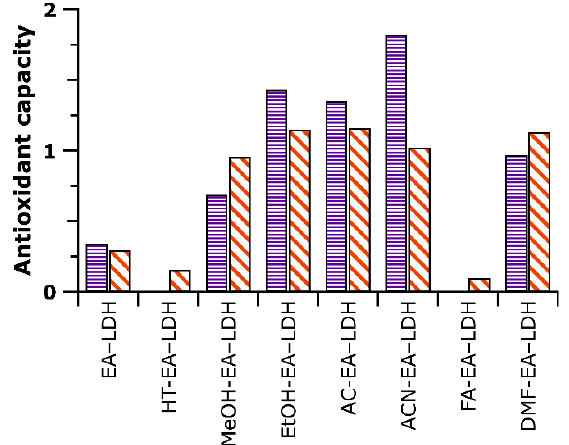
Figure 7. Antioxidant activity data determined in the DPPH and cupric reducing antioxidant capacity (CuPRAC) assays. The purple bars indicate N DPPH values (with 3% error), while the orange striped ones belong to TEAC (with 4% error). Note that HT-EA-LDH and FA-EA-LDH did not decompose 50% of the DPPH radicals. Therefore, no N DPPH values were calculated.